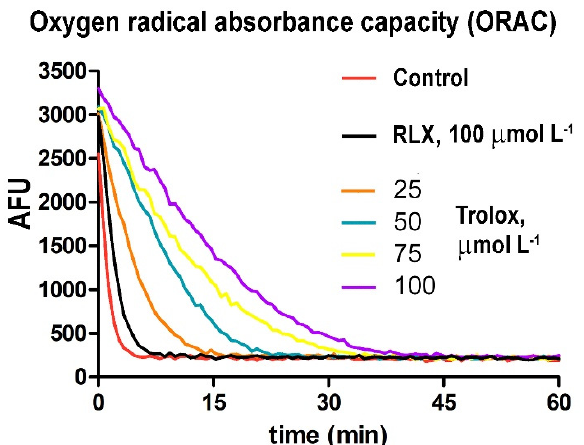
Figure 6. Assay of the chemical antioxidant properties of RLX. The concentration–response curve of O 2• − abatement in the presence of RLX showed no substantial antioxidant effects, at variance with increasing concentrations of the known antioxidant Trolox. Significance of differences (two-way ANOVA; n = 3): RLX vs. Trolox at any concentration, p < 0.001.